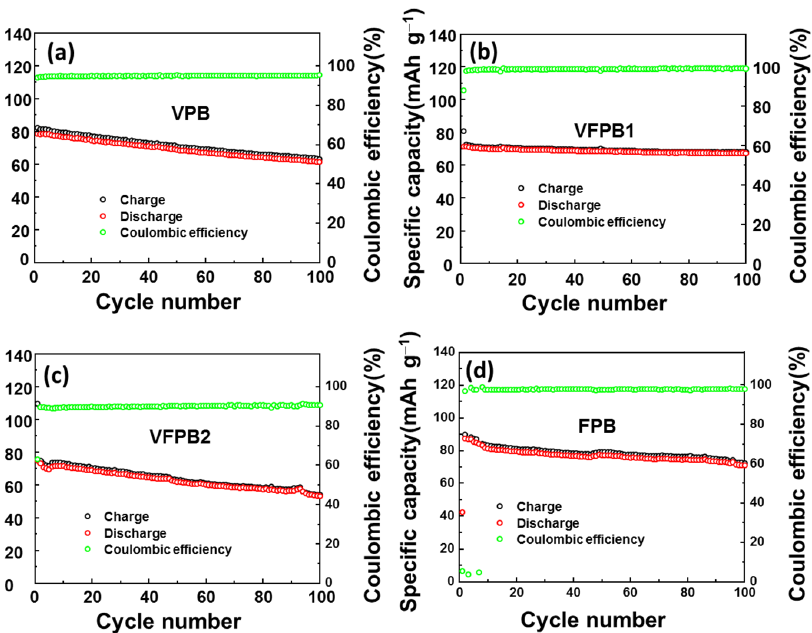
Figure 5. Cycling performances of ( a ) VPB, ( b ) VFPB1, ( c ) VFPB2, and ( d ) FPB cathodes at 50 mA g − 1 over 100 cycles.